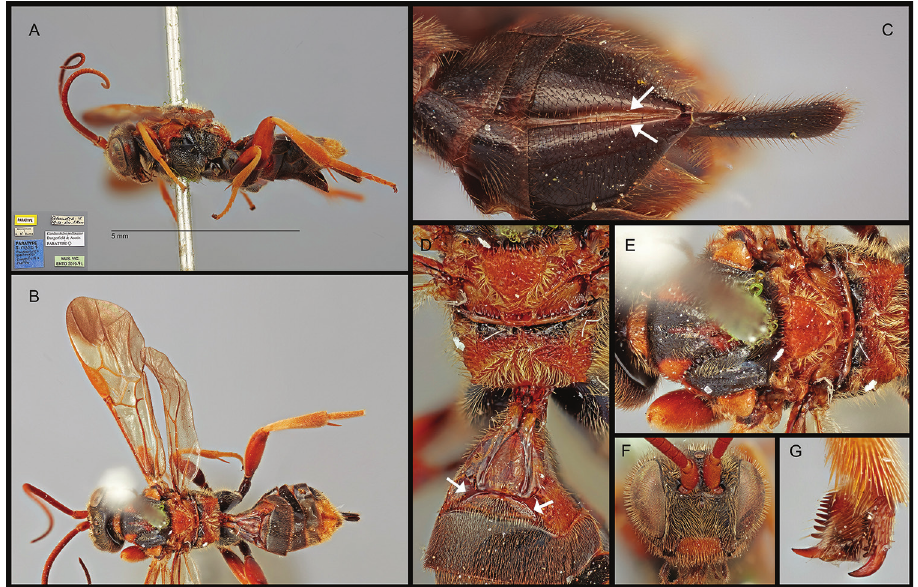
Figure 1. Austerocardiochiles pollinator , paratype. A Lateral habitus B dorsal habitus C ventral meta- soma; arrow: median enfold on hypopygium D dorsal propodeum and metasomal terga 1 to 3; arrow: lens-shaped area E dorsal mesonotum F anterior head G claws.